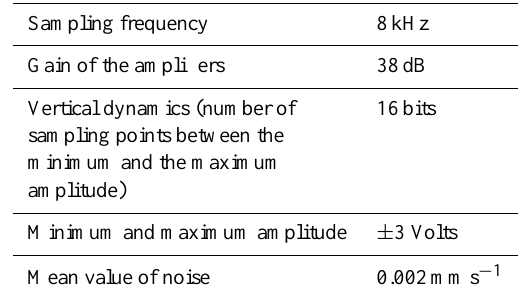
Table 3. Specifications of the acquisition system installed inside the hut.